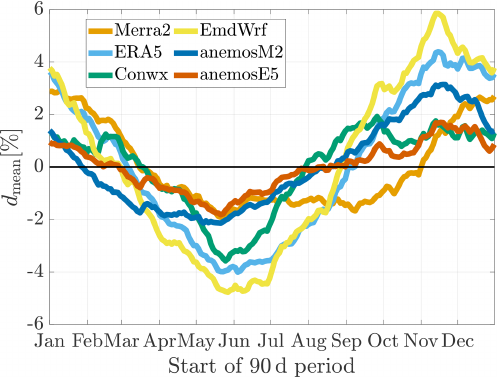
Figure 2. Average annual course of (normalized) wind speed in reanalysis and measurement data. Normalization was done by di- viding the mean wind speeds observed in the 90d periods by the re- spective annual mean. The individual results obtained at the 18 sites were then averaged arithmetically.